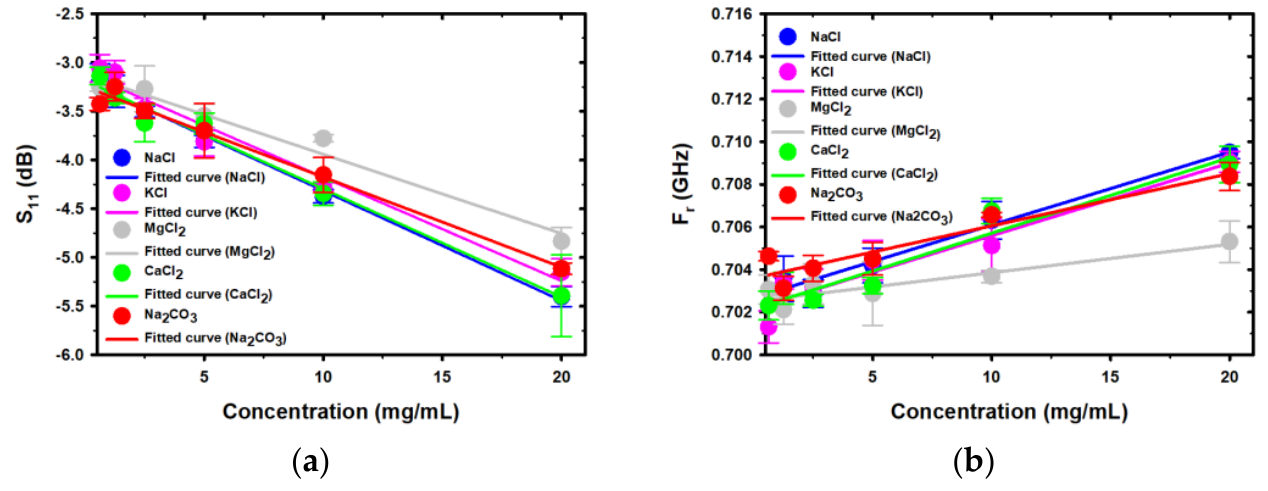
Figure 9. The relationship between the concentration of salt in water in the frequency range of the third resonance peak and the resulting values of ( a ) S 11 and ( b ) F r .